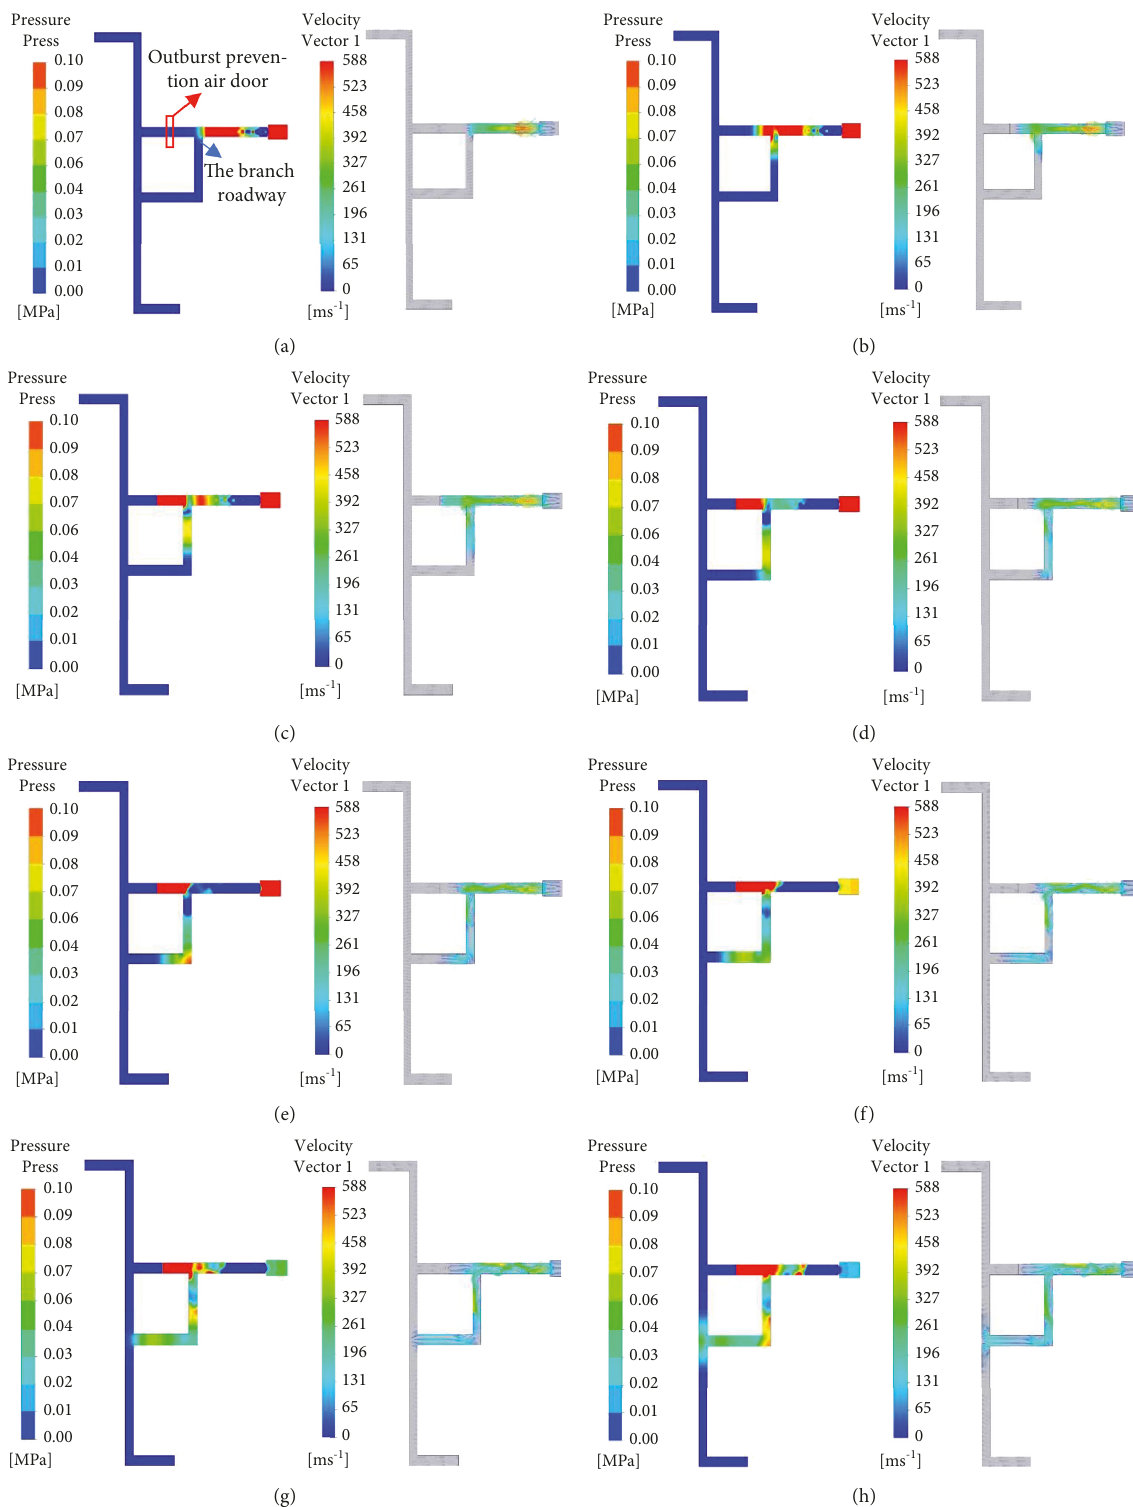
Figure 3: Cloud diagram of pressure and velocity changes in the prominent shock wave at different times. (a) t � 3ms. (b) t � 4 ms. (c) t � 5 ms. (d) t � 6ms. (e) t � 7ms. (f) t � 8 ms. (g) t � 9ms. (h) t �